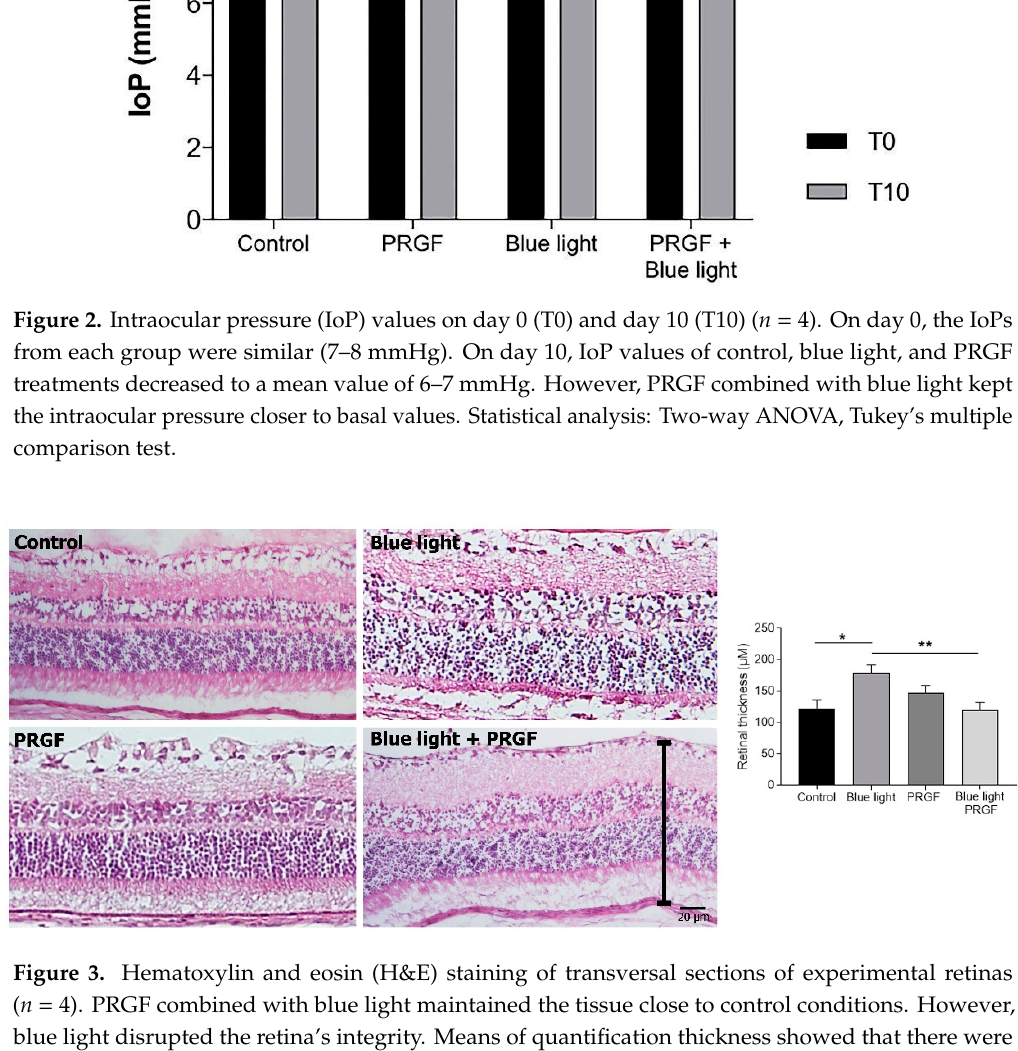
Figure 3. Hematoxylin and eosin (H&E) staining of transversal sections of experimental retinas ( n = 4). PRGF combined with blue light maintained the tissue close to control conditions. However, blue light disrupted the retina’s integrity. Means of quantification thickness showed that there were significant differences between the result obtained from blue-light-exposed retinas and those treated with a combination of blue light and PRGF. Statistical analysis: One-way ANOVA, Sidak’s multiple comparison test, * p < 0.05 and ** p < 0.005. Scale = 20 µm.